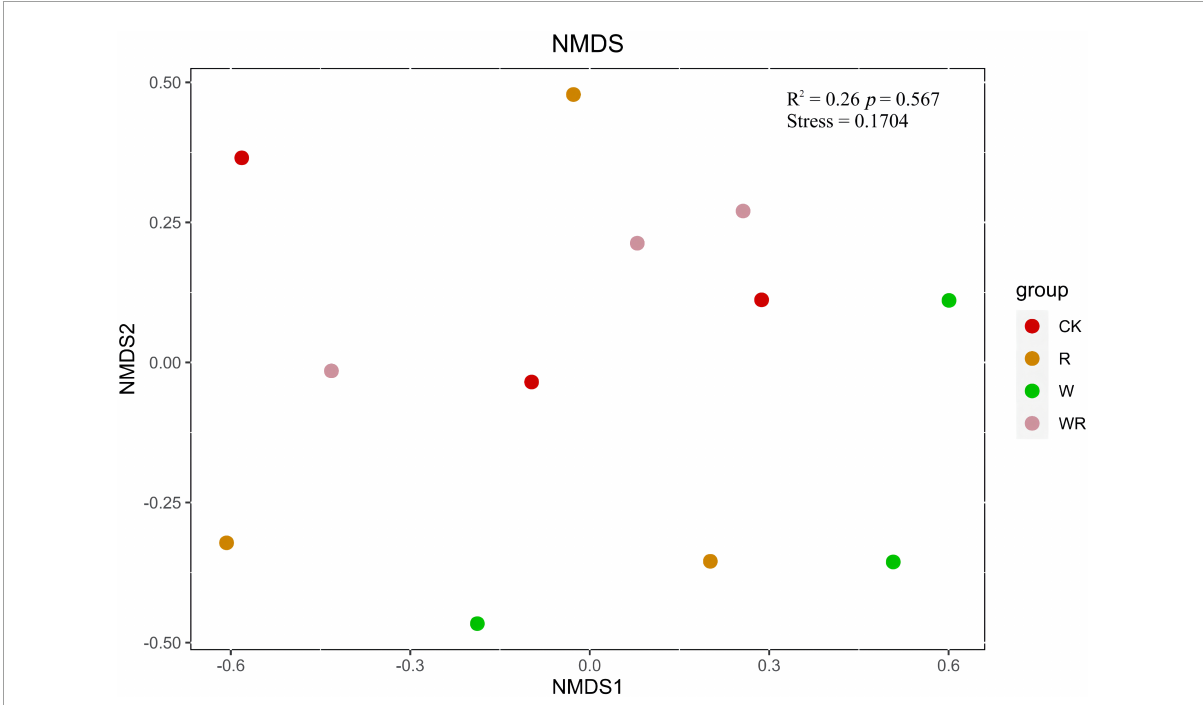
FIGURE3 The NMDS plot of methanogenic communities based on Bray–Curtis distance. CK, Control (no warming or drought); W, warming; R, 20% drought; WR, warming + 20% drought.